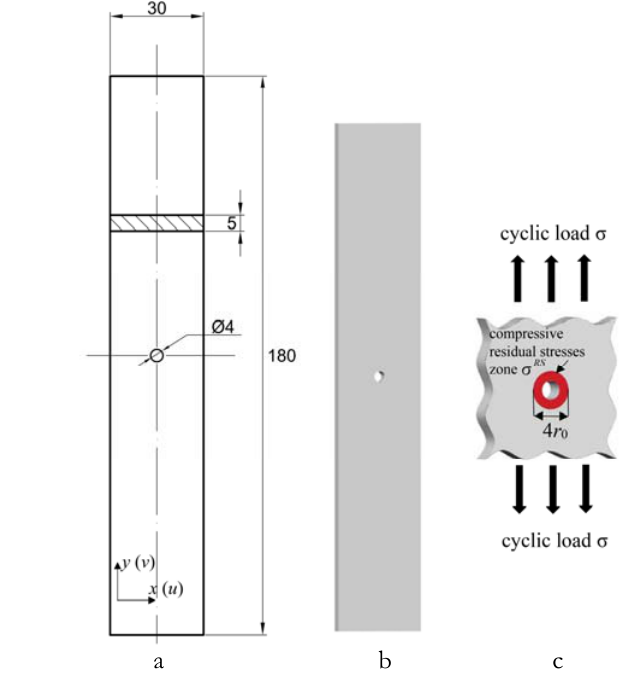
Figure 1: Drawing of specimens of Т 5H type. (a) scheme, (b) 3D view, (c) cyclic loading of cold-expanded